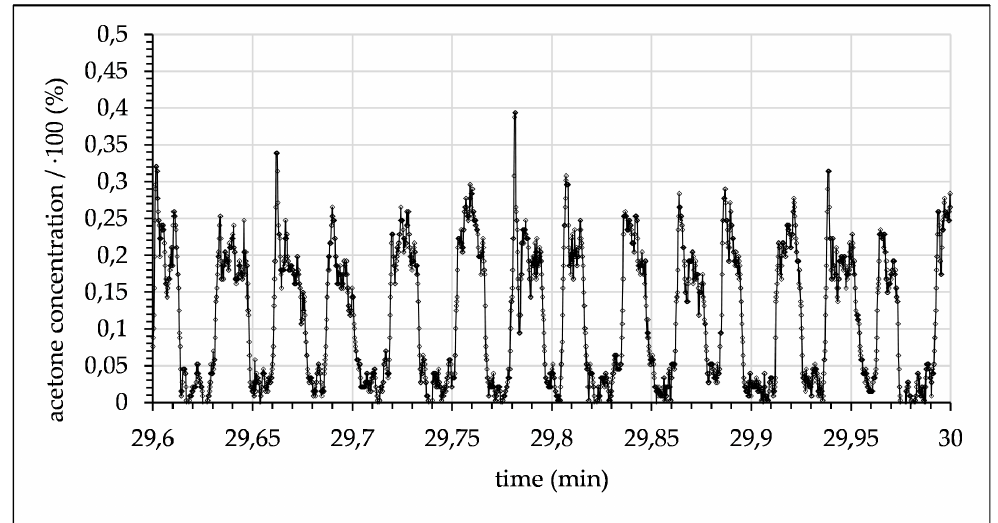
Figure 10. Measured acetone concentration in toluene droplets alternating with water droplets (0.04 mL/min with 3.75 s time delay after contact of toluene and water).